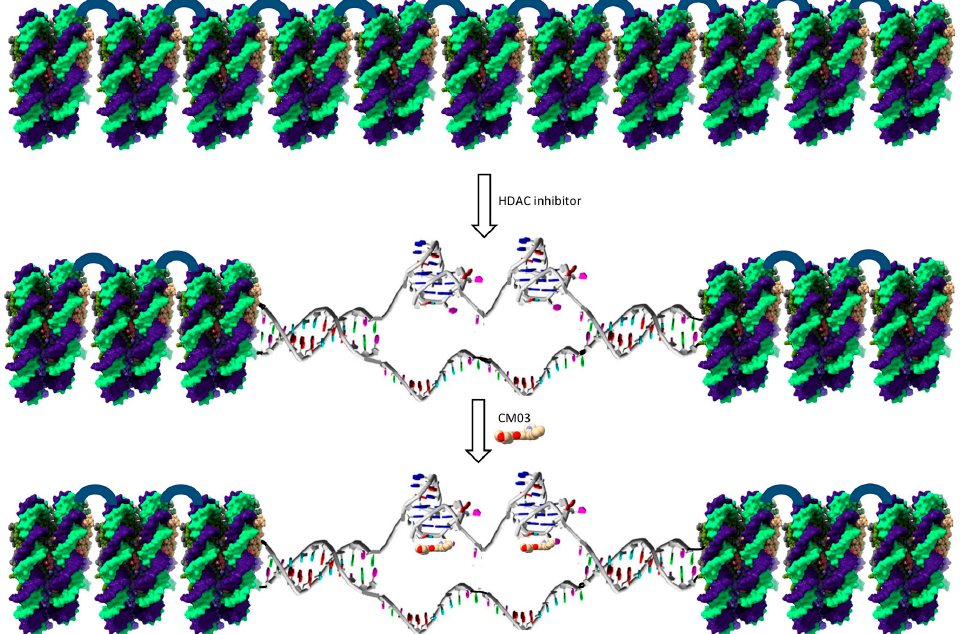
Figure 6. Schematic of effects of CM03 and HDAC inhibitors on chromatin. The top figure shows a stretch of packed nucleosomes. The middle figure shows an effect of the HDAC inhibitor SAHA, inhibiting chromatin remodeling and exposing active chromatin, including genes with G4-forming sequences. The bottom figure shows the stabilization of these G4s by a G4 ligand such as CM03. Then, these stabilized G4-ligand complexes would inhibit the progression of RNA polymerase and lead to inhibition of the transcription of the gene involved.